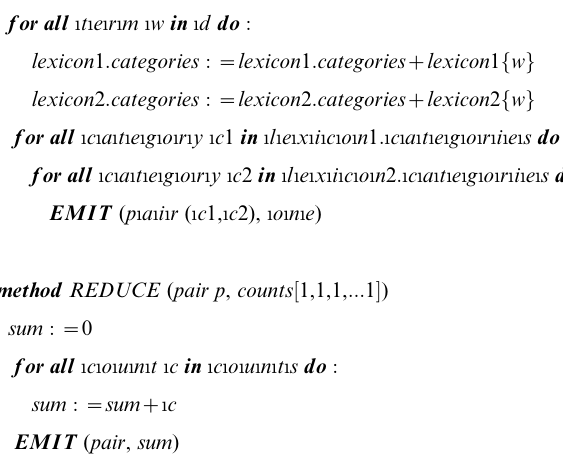
Figure S1 Gene term occurrences in the literature. A bar chart representation with genes on the y-axis and publication counts on the x-axis. Only the genes with high literature occurrences are